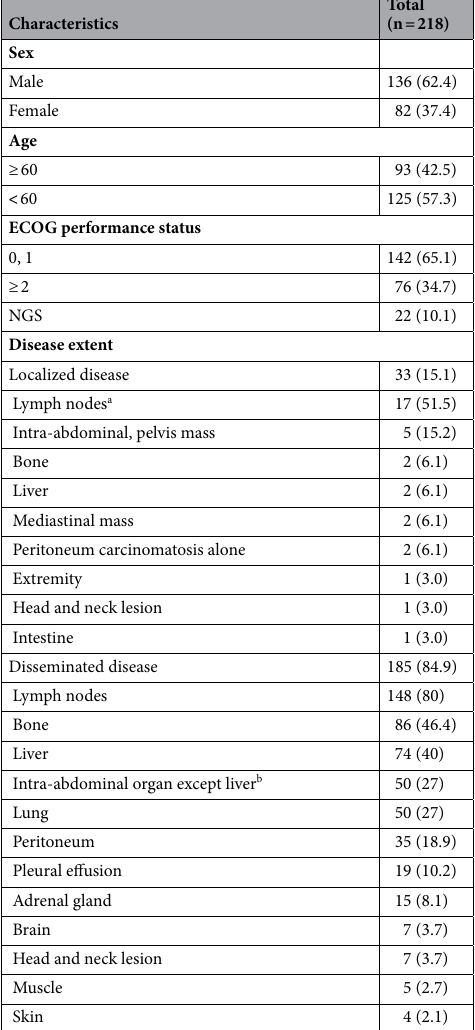
Table 1. Baseline characteristics of the study patients. Values are n (%). ECOG Eastern Cooperative Oncology group, NGS next-generation sequencing. a Includes cervical (10), Inguinal (5), hepatoduodenal (1) and axillary (1) lymph nodes. b Includes pelvic mass (8), pancreas (7), Gallbladder (7), Ovary (6), intestine (6), stomach (4), intra-abdominal mass (3), spleen(3), kidney and ureter (3), retroperitoneal mass (2), and